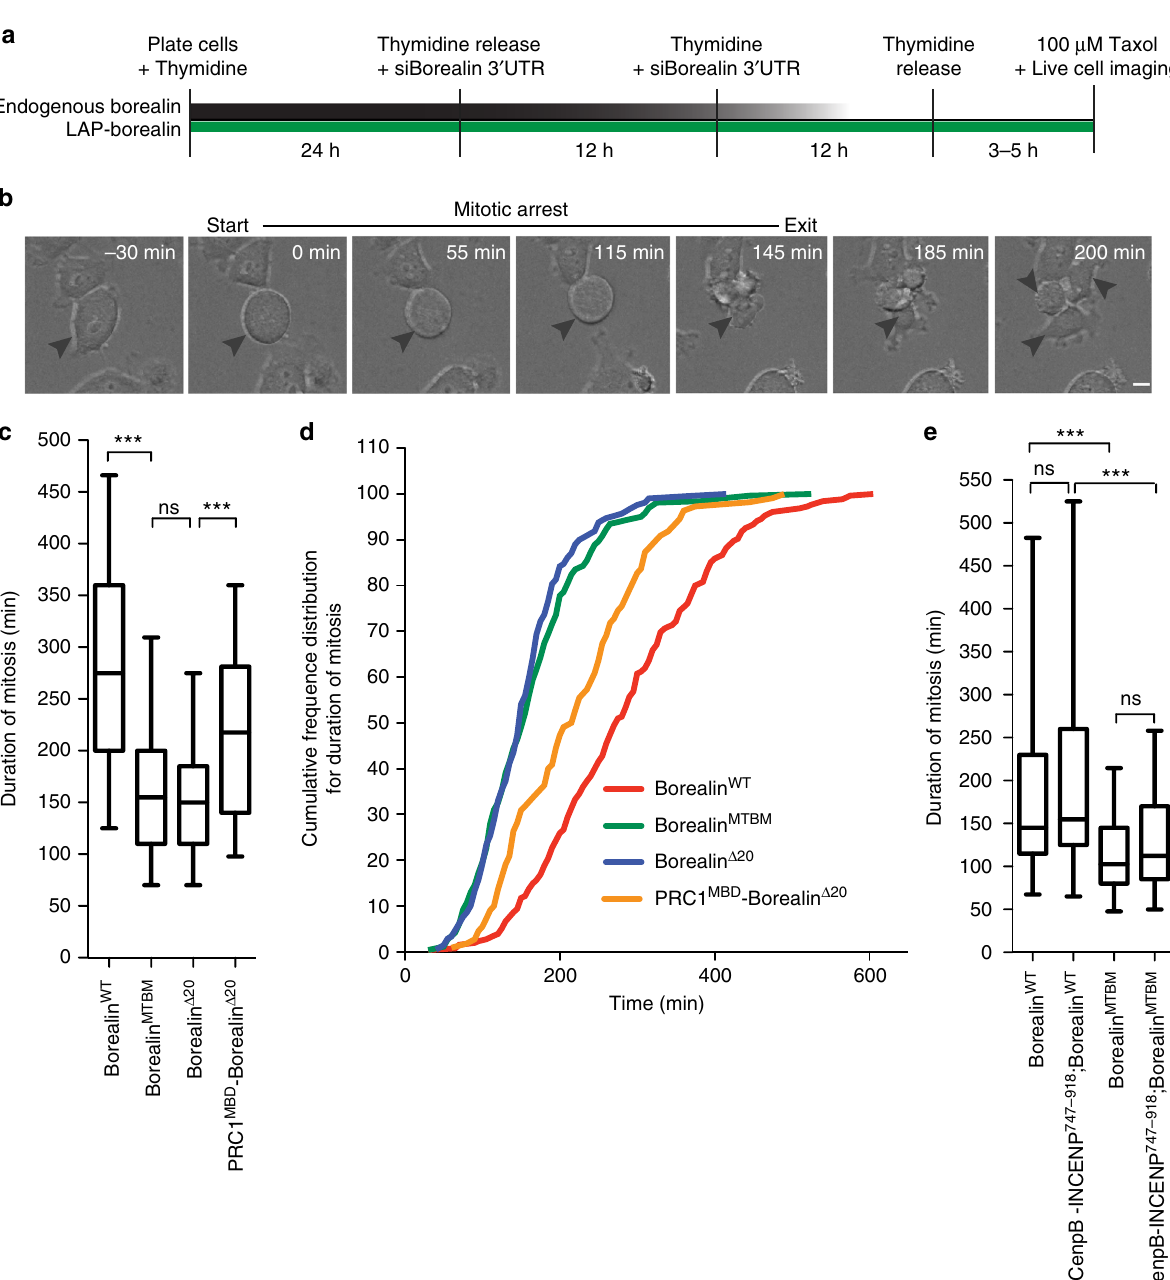
Fig. 3 CPC-microtubule interaction is important for maintenance of taxol dependent spindle assembly checkpoint arrest. a Schematic of